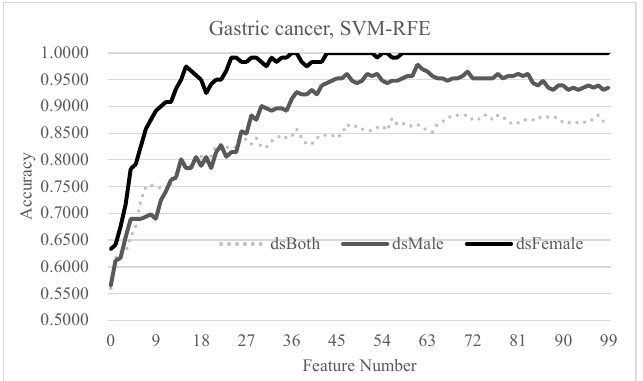
dataset was Acc = 0.8835 using 68 features. However, the sex-specific models achieved the best accuracies of 1.0000 using 36 features and 0.9784 using 61 features for the female and male samples, respectively. male samples, respectively. male samples, respectively.